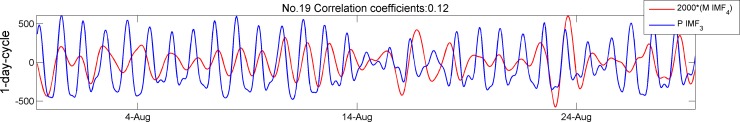
Enlarged view of 1-day cycle